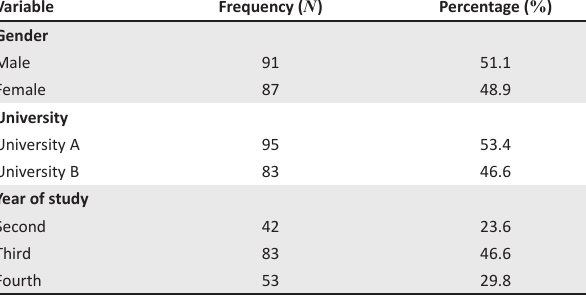
TABLE 1: Demographic characteristics of the respondents ( n =